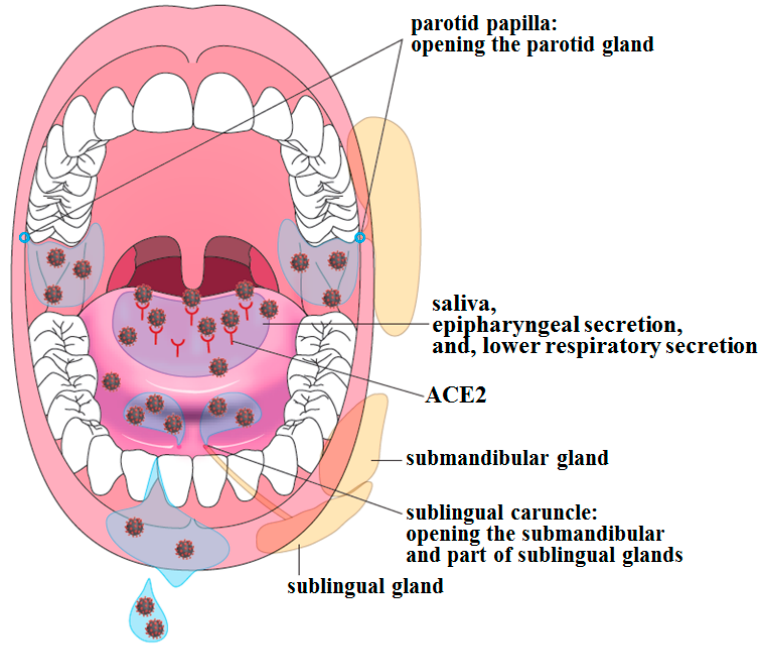
Figure 4. Relationship between ACE2 expression in the oral cavity and SARS-CoV-2 being de- tected in saliva. ACE2 is expressed on the oral mucosae, particularly on the dorsum of the tongue and on the gingiva, suggesting that the oral mucosae can be infected with SARS-CoV-2 and that oral bacteria present may interact with SARS-CoV-2. The infection of salivary glands themselves with SARS-CoV-2 has recently been reported [18]. A myriad of viruses has been detected in saliva, and this has led to measures on how to prevent droplet and aerosol transmissions. This also means that saliva can be used as a specimen for testing viral infection.